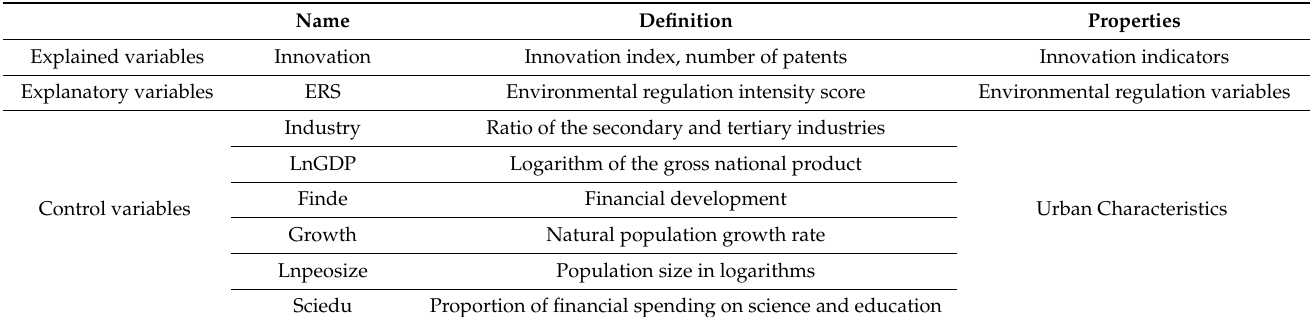
Table 1. Setting of the main variables.